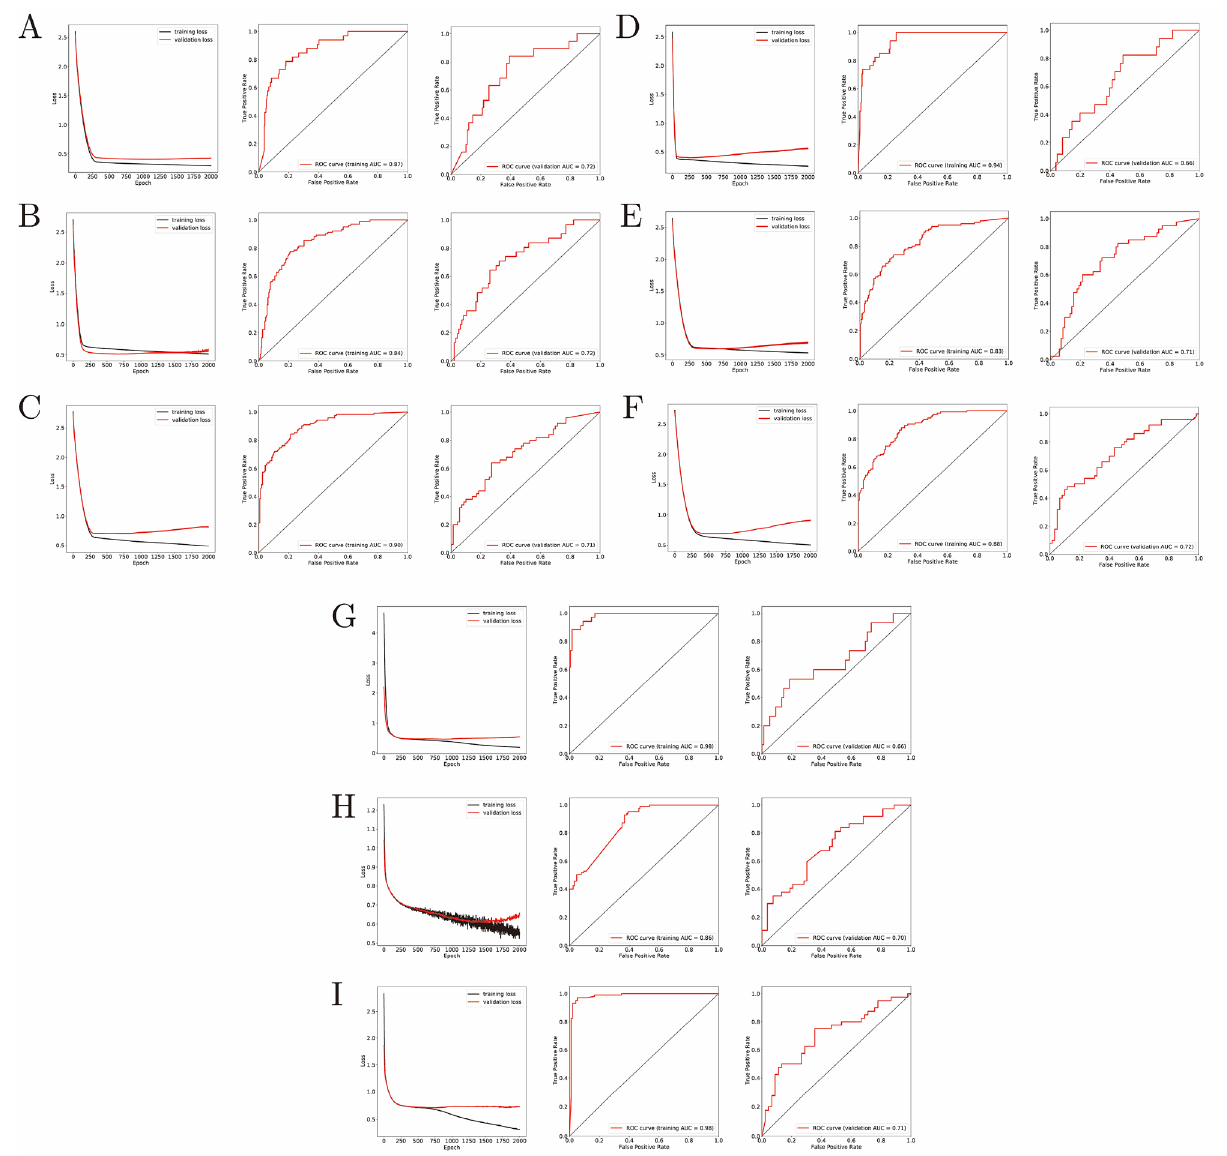
Figure 8. Efficiency estimation of six ANN predictors. ( A–C ) Loss curve, ROC of training set and validation set of models aiming at one-, three- and five-year OS prediction based on GSE84437. ( D–F ) Loss curve, ROC of training set and validation set models aiming at one-, three- and five-year RFS assessment based on GSE26253. ( G–I ) Loss curve, ROC of training set and validation set models aiming at one-, three- and five-year RFS assessment based on GSE66229, with only transcriptional data of SNX family